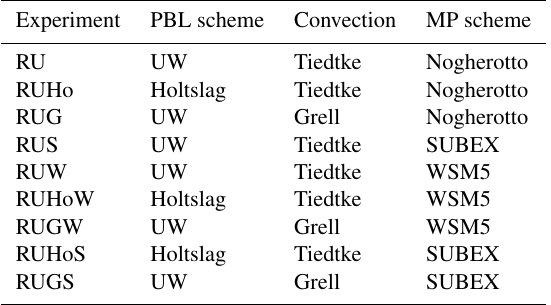
Table 2. RegCM setups.